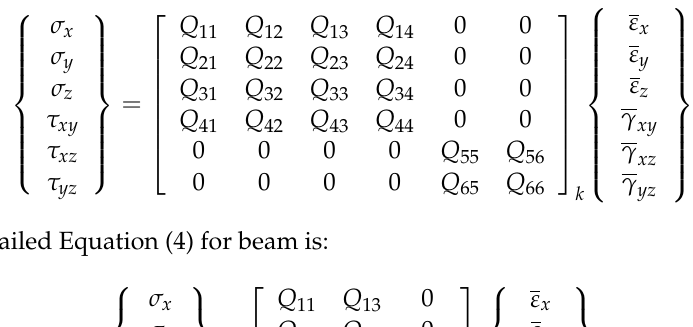
Figure 3. Out-of-transverse displacement fields.